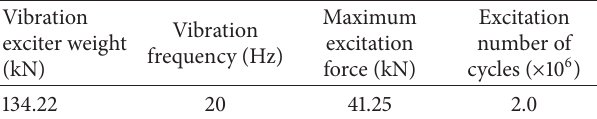
Table 2: Loading indices of cyclic loading